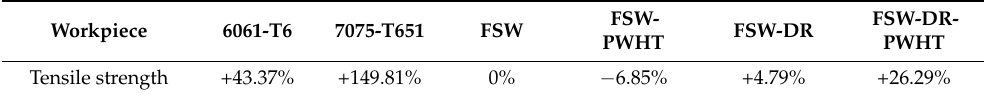
Table 9. Comparison of the tensile strengths of the workpieces.